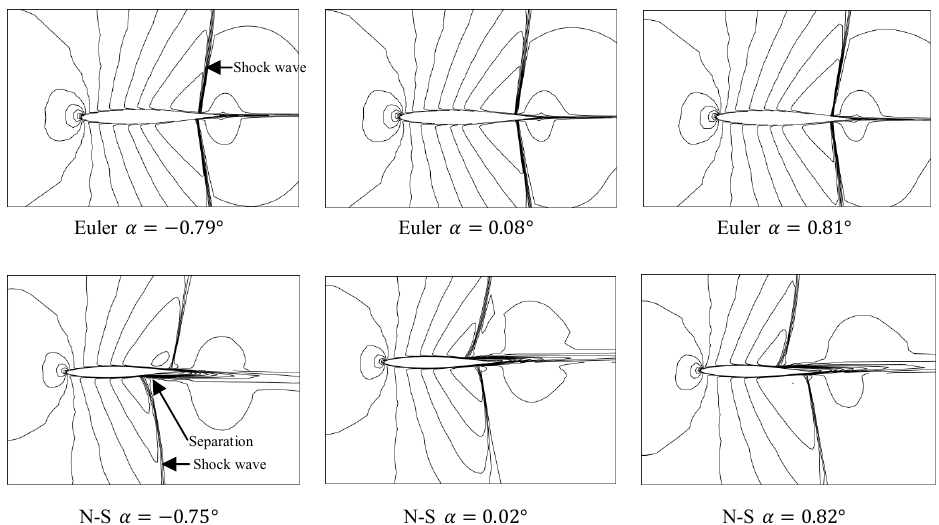
Fig. 6 Positions of shock waves and separations between Euler and Navier-Stokes during aeroelastic response ( M (cid:3404) 0.875 ). (cid:2998) The flutter boundary is presented in Fig. 7 for comparison with previous results by TSP and Euler solvers. The transonic dip is well predicted by all of the results. The bottom of the =0.85 and all the results deviate less than 10% from this value except the dip is close to M (cid:2998) Navier-Stokes solution. However, the discrepancy occurs in the Mach number range 0.875< M <1.0. Multiple flutter points are observed at a range of Mach numbers in the (cid:2998) =0.85 in the results of Alonso & Jameson (1) and Edwards (8) while neighbourhood of M (cid:2998) =0.9 in the results of Bendiksen similar behaviour is observed in the neighbourhood of M (cid:2998) & Kousen (6) and the present Euler solver. The disagreement in the Euler results in this range can only be explained by the different spatial meshes used. C type mesh is used in Bendiksen & Kousen (6) and present study while an O type mesh is used by Alonso & Jameson (1) . These multiple flutter points might be tried since the TSP and Euler solvers did not provide any results in the Mach number region of 0.85< M <0.9. The flutter points over (cid:2998) =0.9 are only obtained with a TSP solver while the Euler solver and the M (cid:2998)